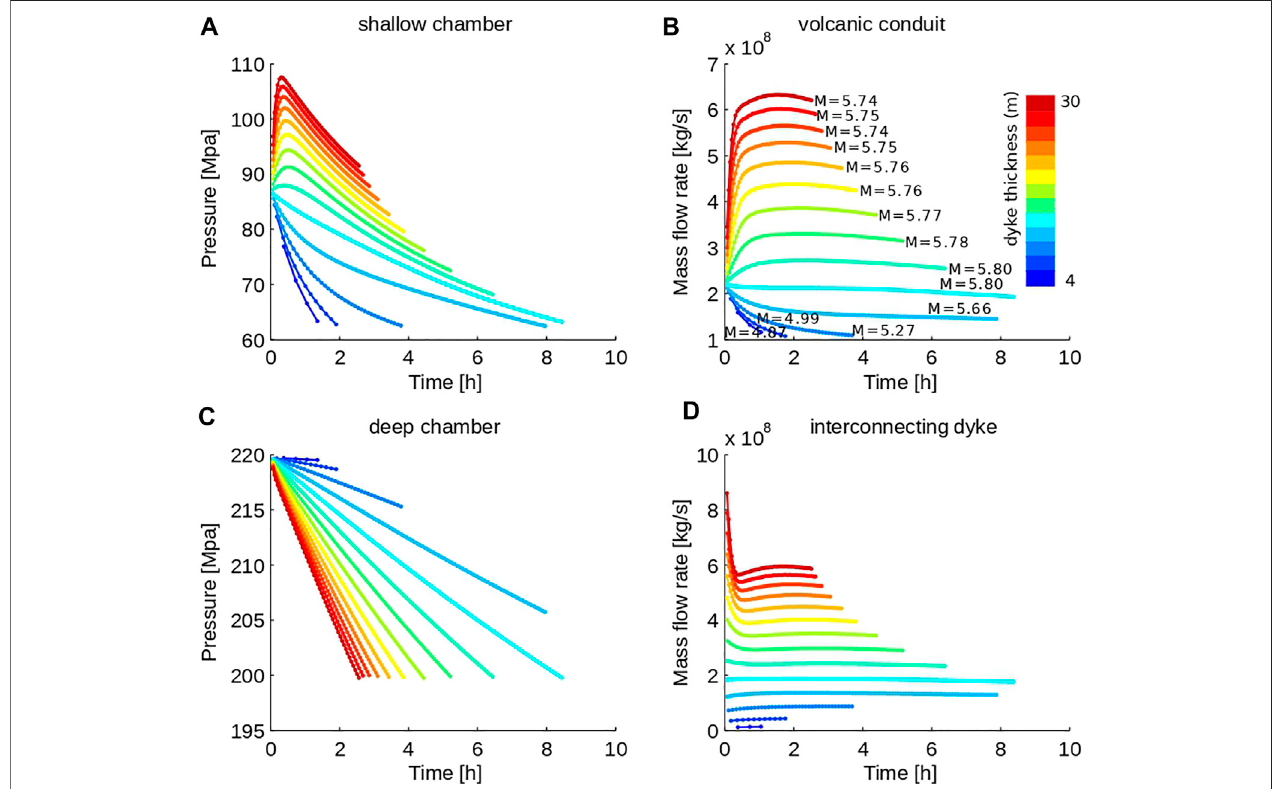
FIGURE 7 | Computed pressure in the shallow and deep magma chambers, and mass fl ow rate along the conduit and dyke. Calculations corresponding to dyke thicknessesfrom 4 (cold colors) to30(hotcolors) m, with regulardyke thickness increment by2 m. Other simulationconditions: deepchamber volume (cid:2) 200km 3 ; shallow chamber volume (cid:2) 3km 3 ; depth of the shallow chamber (cid:2) 3 km; conduit diameter (cid:2) 90 m; total volatile contents: H 2 O in dacite (cid:2) 4.5 wt%, CO 2 in dacite (cid:2) 1 wt%,